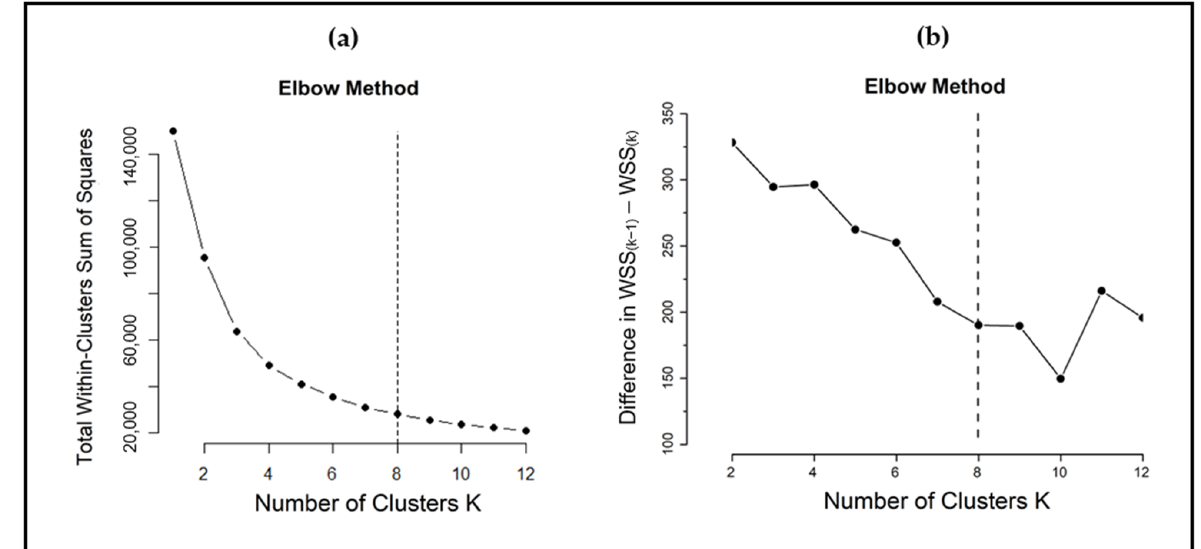
Figure 3. ( a ) Curve obtained by the formal Elbow method and ( b ) curve obtained by linearly plotting WSS (k − 1) − k . Both curves are derived from the K-means cluster analysis applied to the entire SA region’s monthly rainfall CPC data (1993–2016).